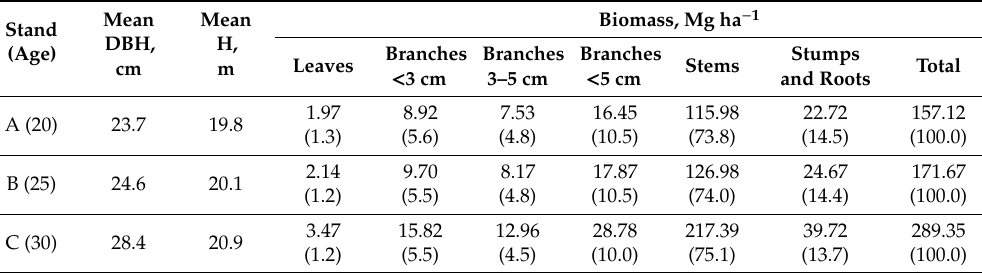
Table 1. Dry mass of leaves, branches, stems, and stumps and roots in rubber tree plantations that were 20, 25, and 30 years of age. The top number in each cell is the biomass, and the lower number in parentheses is the percentage of total biomass. DBH: diameter at breast height, H = height.